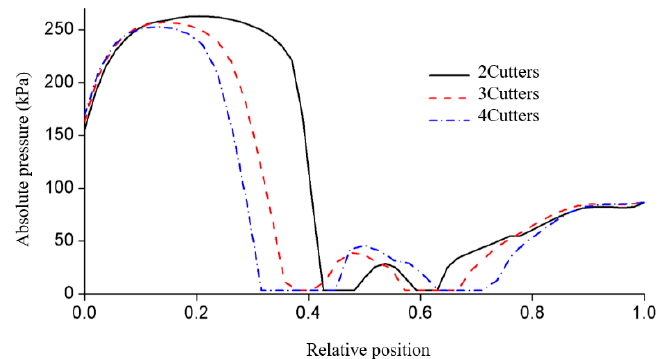
Figure 16. Surface pressure distribution of the different numbers of cutter heads.